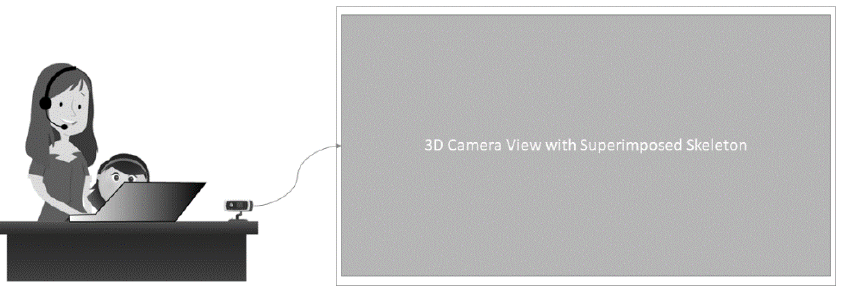
Figure 3. Local workstation setting (left) for physical telerehabilitation session, with acquired video for videoconferencing (right).